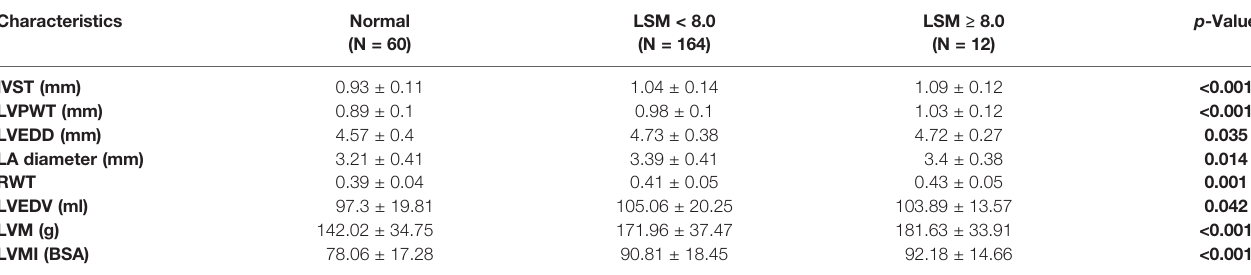
TABLE 5 | Comparison of cardiac structure according to liver fi brosis status.